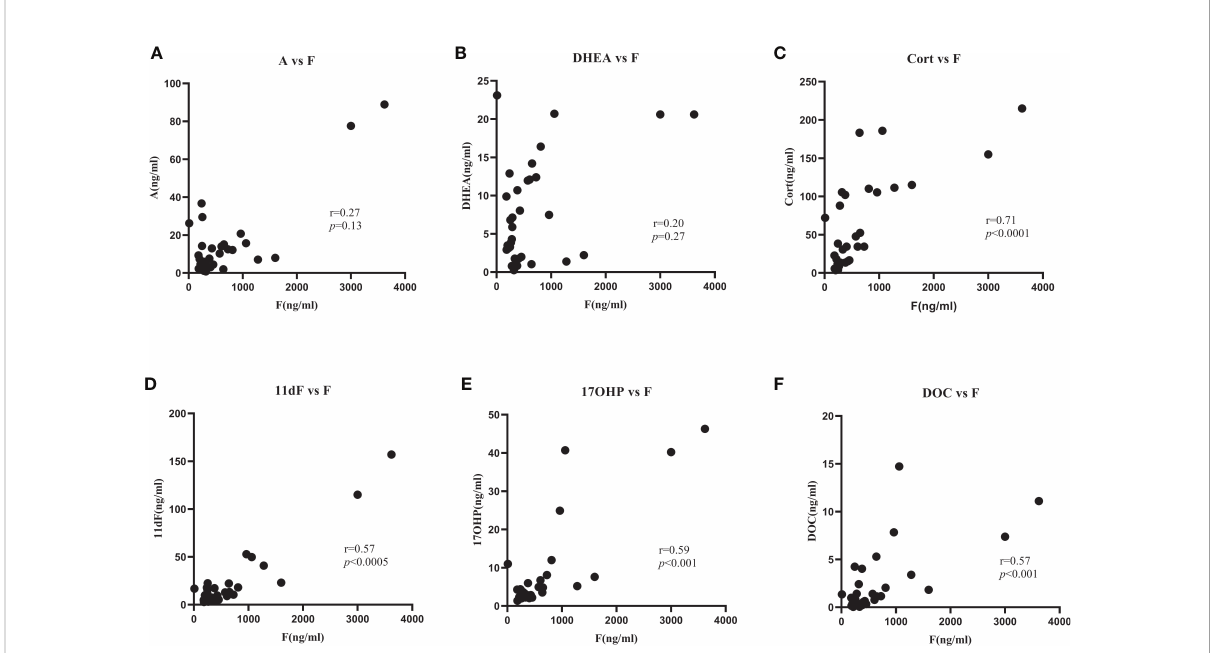
FIGURE 2 Correlation of cortisol vs six steroids with high gradient of concentration from adrenal vein to peripheral vein: androstendione ( A ), DHEA ( B ), corticosterone ( C ), 11-deoxycortisol ( D ), 17-hydroxyprogesteron ( E ), 11-deoxycorticosterone ( F ). F, cortisol; A, androstenedione; DHEA, dehydroepiandrosterone; Cort, corticosterone; 11dF, 11-deoxycortisol; 17OHP, 17-hydroxyprogesterone; DOC, 11-deoxycorticosterone.